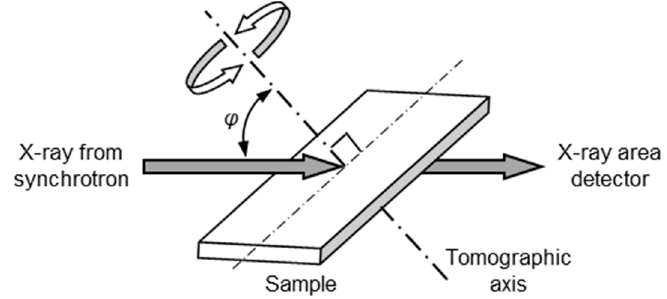
Figure 8. The sample arrangement for synchrotron radiation (SR)-based computed laminography (CL).